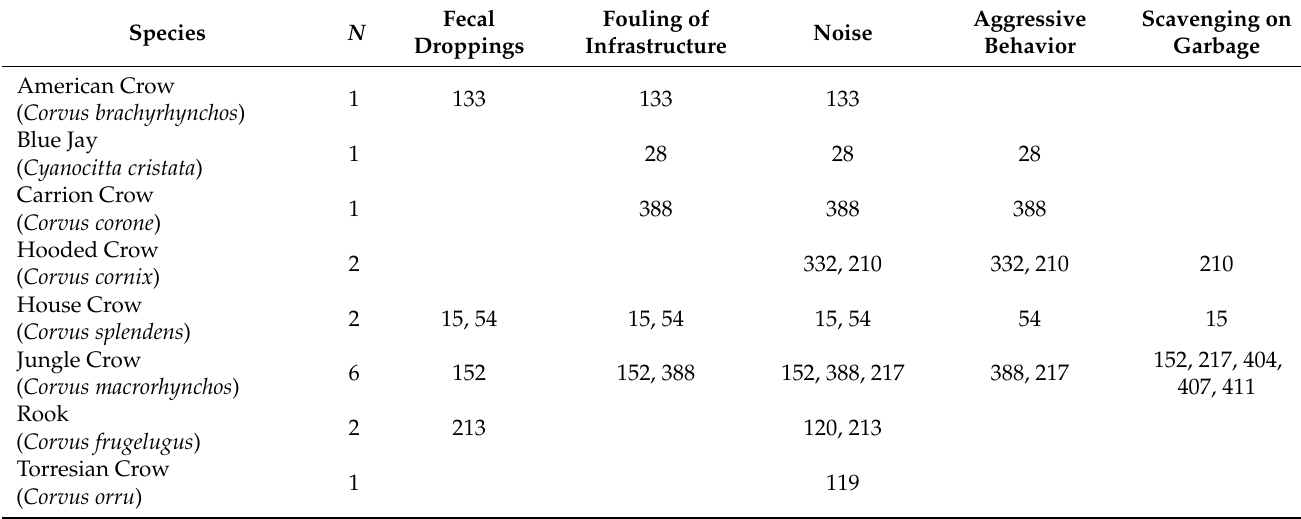
Table 11. List of articles reporting different kinds of human-crow conflicts ( n = 15). The reference numbers in the table refer to the individual publication numbers given in Table